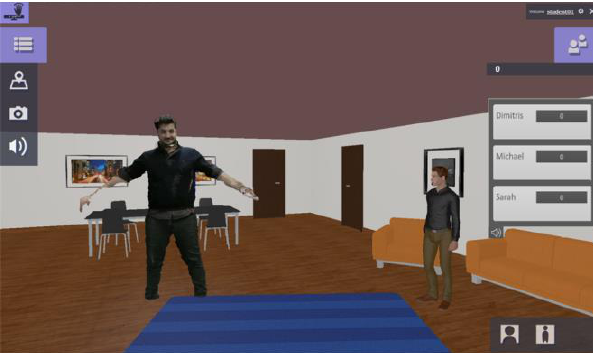
Figure 2. REVERIE Hangout UI: account information on the upper-right corner, user viewpoint on the lower-right corner, main functionalities menu and gestural functionalities selection icon on the upper-left